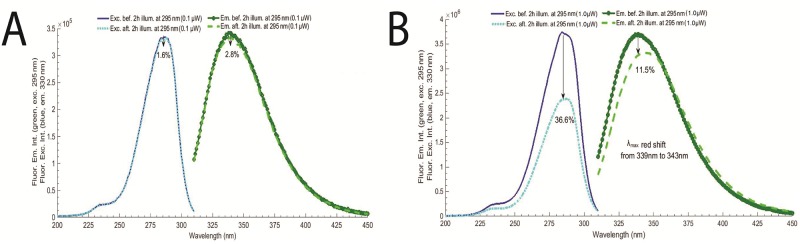

A) LYZ fluorescence excitation and emission spectra before and after LYZ 295 nm 2hours excitation, with slit opening fixed at 0.1 mm (0.1 μW). B) LYZ fluorescence excitation and emission spectra before and after LYZ 295 nm 2hours excitation, with slit opening fixed at 0.5 mm (power: 1.0 μW). Fluorescence excitation was fixed at 295 nm and fluorescence emission at 330 nm.